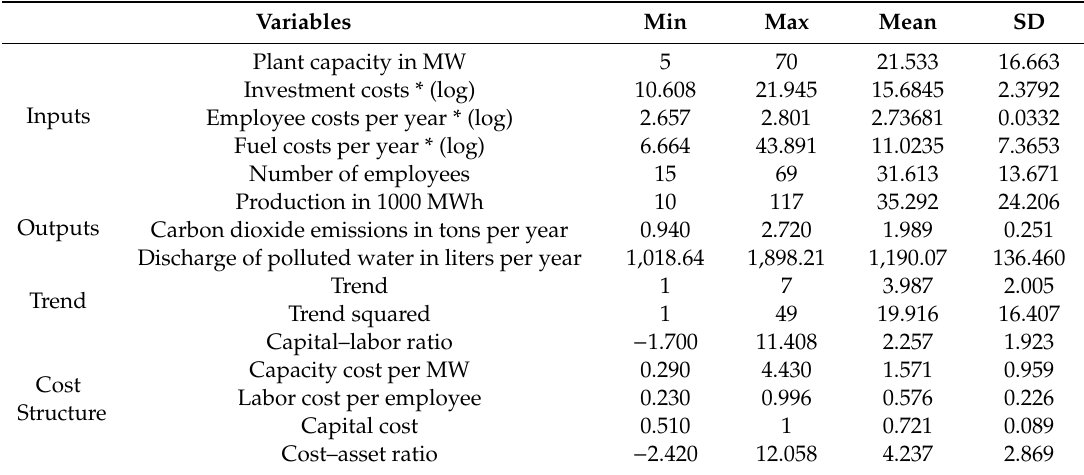
Table 2. Descriptive statistics for the